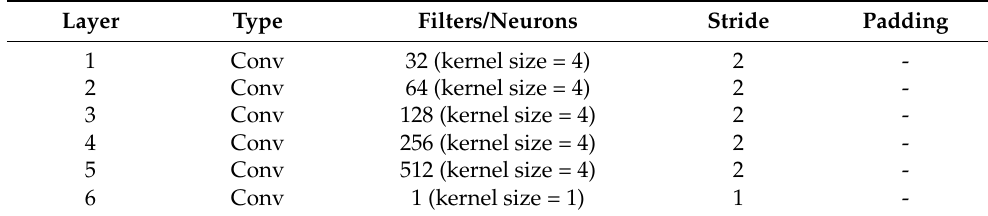
Table 4. Structural parameters of the